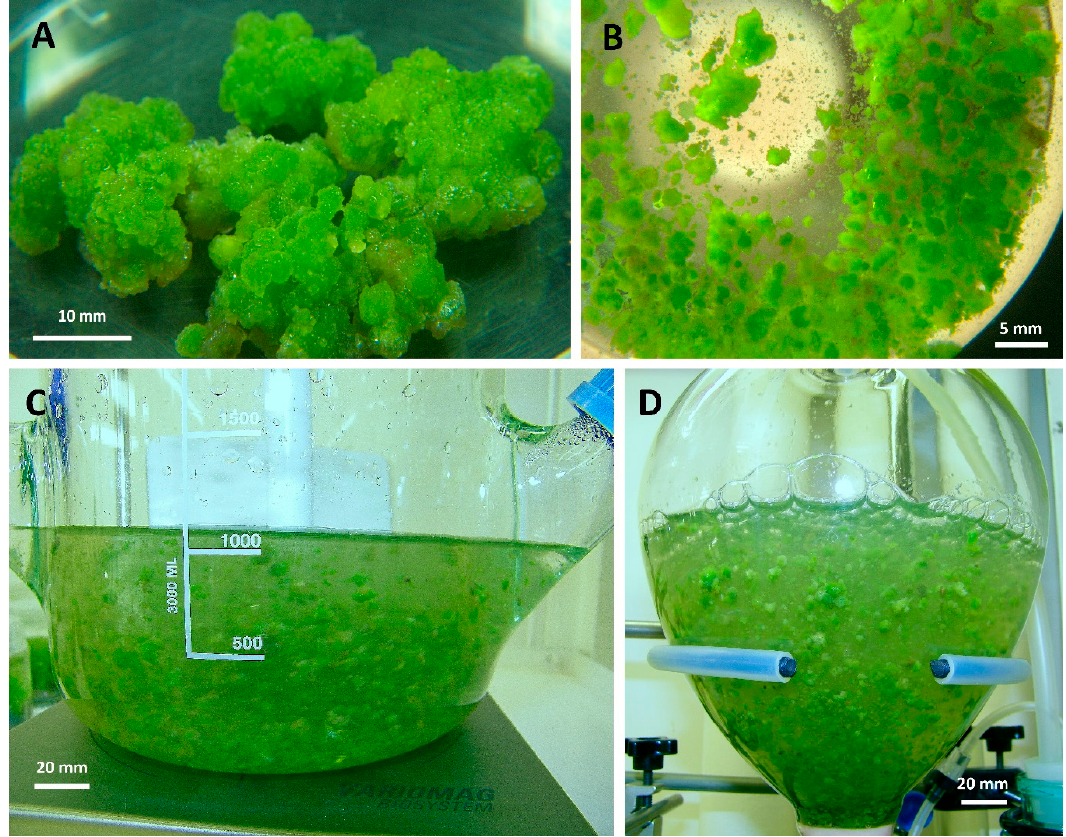
Figure 1. Different types of in vitro cultures of Verbena officinalis investigated in the study: ( A ), callus cultures (photograph without culture vessel); ( B ), suspension cultures grown in shake flasks (bottom view); ( C ), suspension cultures grown in stirred-tank bioreactor (STB); ( D ), suspension cultures grown in balloon bioreactor (BB). White bars indicate scale.